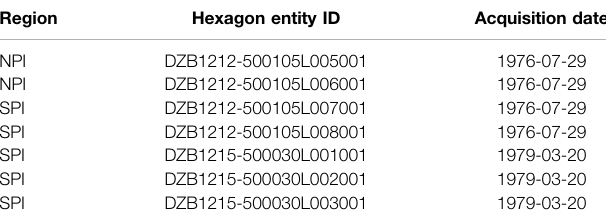
TABLE 1 | Entity IDs of downloaded hexagon